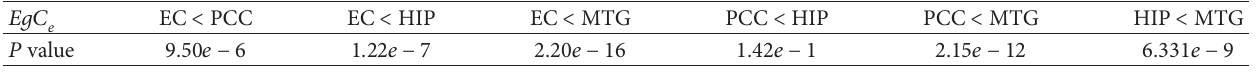
Table 9: Comparison of mean eigenvector centrality scores ( 𝐸𝑔𝐶 𝑒 ) of low TO genes between brain regions. 𝐸𝑔𝐶 < PCC EC < HIP EC < MTG PCC < HIP PCC < 𝑒 EC